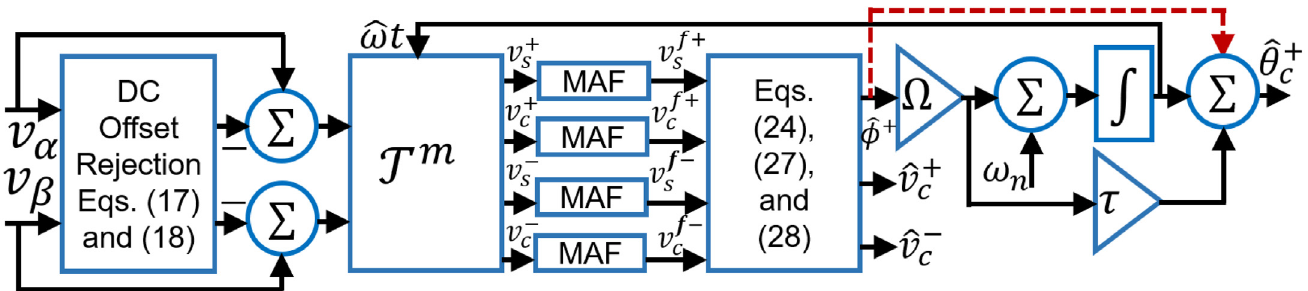
Fig 1. Block diagram of the proposed